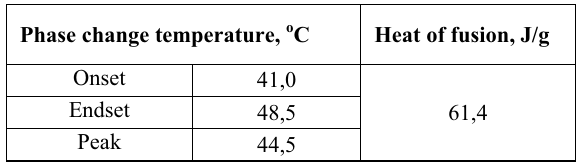
Table 2. Heat of fusion and transition temperature